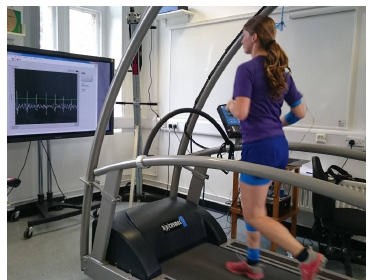
Figure 1. Participant during feedback condition. Screen shows the tibial acceleration signal (white peaks) together with the target (green